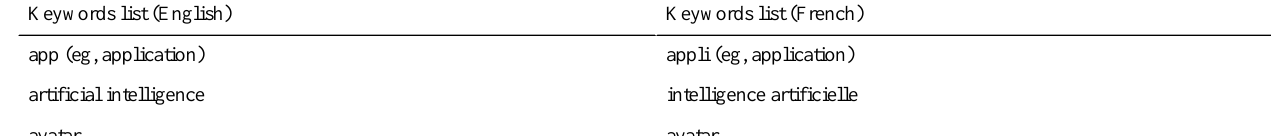
Table 1. List of English and French keywords a used to search the documents.